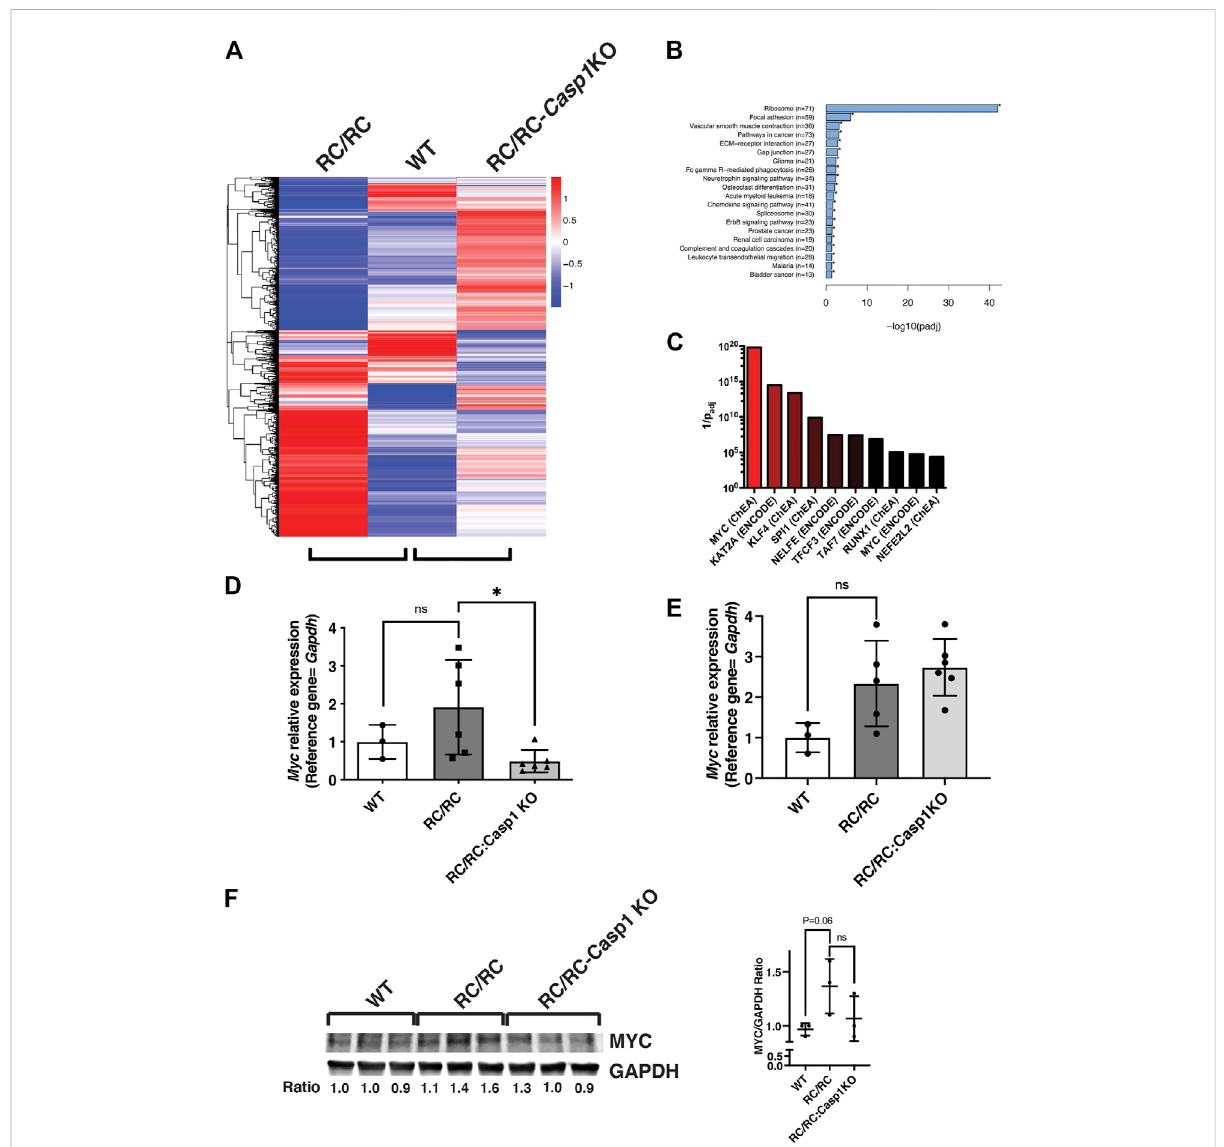
The MYC pathway in RC/RC mice is downregulated by Casp1 KO in females but not males. (A) RNA was isolated from kidneys of 6 month-old RC/RC, WT, and RC/RC: Casp1 KO mice (2 males and 2 females per group). RNAseq was performed, and hierarchical cluster analysis of differentially expressed genes was used to compare gene expression patterns from each group. Hierarchical clustering analysis was carried out with the log10(FPKM+1)ofuniondifferentialexpressiongenesofallcomparisongroups.Differentialexpressionanalysisbetweentwoconditions/groups was done by using the DESeq2 R package, with the signi fi cance criterion being p adj < 0.05. Color descending from red to blue indicates log10(FPKM+1), from large to small. (B) ClusterPro fi ler software was used to perform KEGG (Kyoto Encyclopedia of Genes and Genomes) pathway enrichment analysis from the RNAseq data (males and females). Shown are pathways signi fi cantly enriched among all the 3162 DEGs in RC/RC vs. RC/RC: Casp1KO kidneys. Pathways are ranked by -log10 (p adj ). Shown in parentheses are the number of genes mapped to each pathway. (C) Genes signi fi cantly downregulated in male and female RC/RC: Casp1KO kidneys compared to RC/RC kidneys were analyzed using the web-based tool ENRICHR (see text for references). Transcription factors that are present in ENCODE and ChEA databases were matched with consensus target genesfromwithinthisgeneset.The y -axisrepresents1/p adj . (DandE) qRT-PCRof Myc transcriptsfromkidneysof6 month-oldWT,RC/RC,andRC/ RC: Casp1 KO female (D) and male (E) mouse kidneys (* p < 0.05; t test). (F) Western blots of MYC and GAPDH from whole protein samples isolated from the kidneys of 6 month-old WT, RC/RC and RC/RC: Casp1 KO female mice (3 each). The ratio of MYC/GAPDH is shown beneath each sample and is plotted in the graph to the